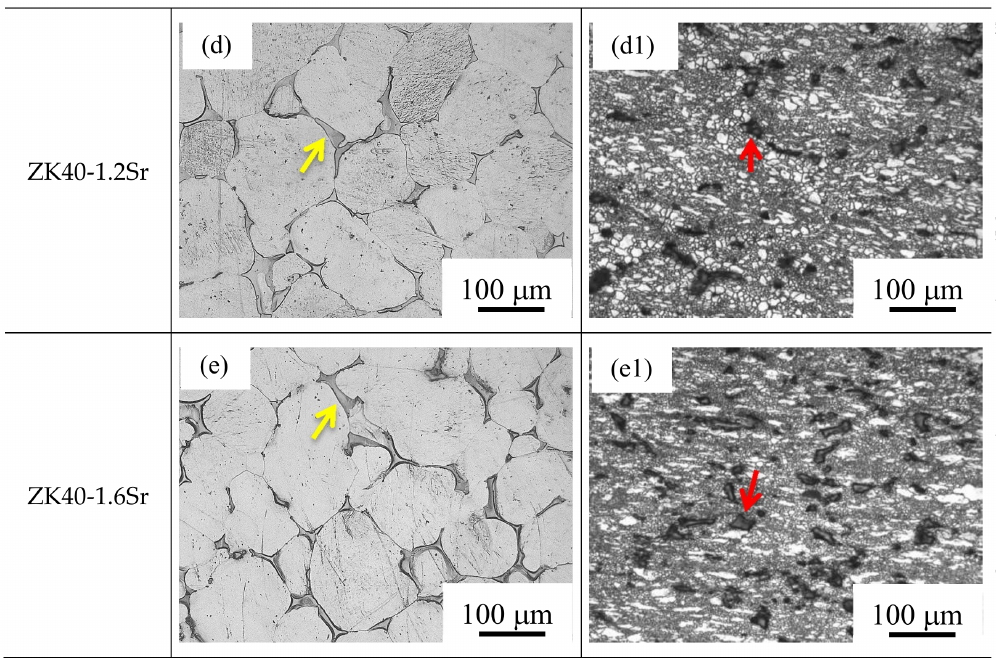
Figure 1. Optical microscopy images of the as-cast and bi-directional forging (BDF) ZK40-xSr alloys: ( a , a1 ) ZK40; ( b , b1 ) ZK40-0.4Sr; ( c , c1 ) ZK40-0.8Sr; ( d , d1 ) ZK40-1.2Sr; ( e , e1 ) ZK40-1.6Sr.